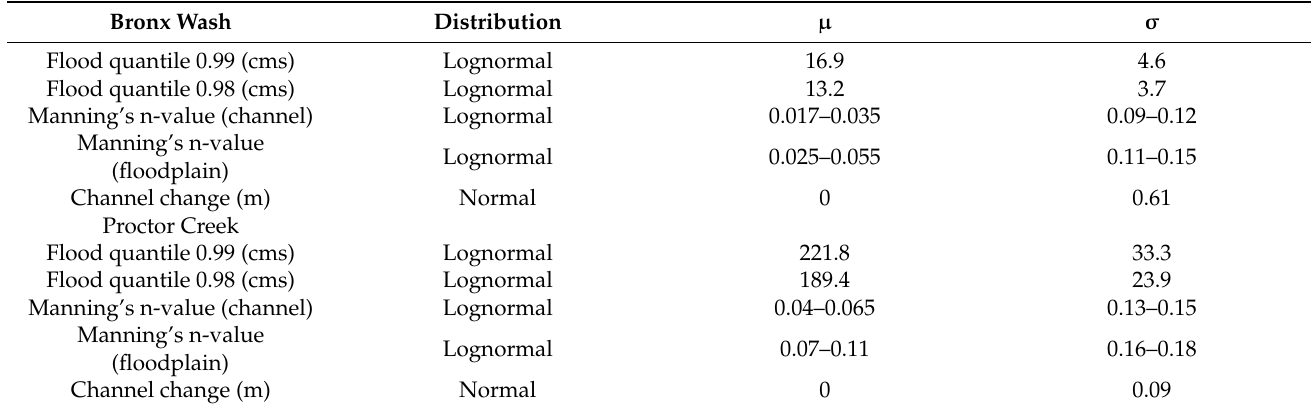
Table 2. Sample parameterization for